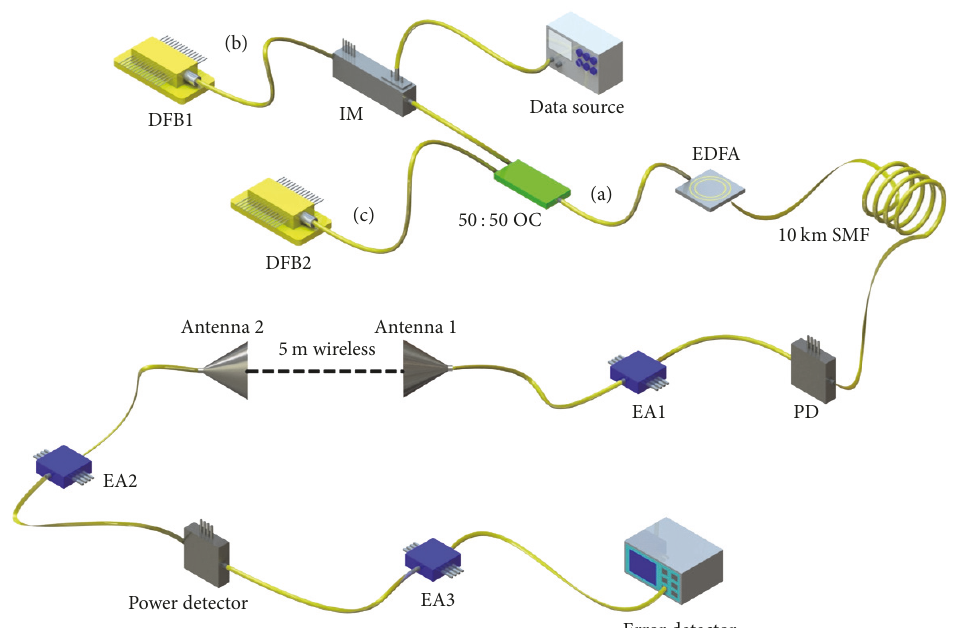
Figure 7: Experimental setup of radio-over-fiber system with 0.1THz